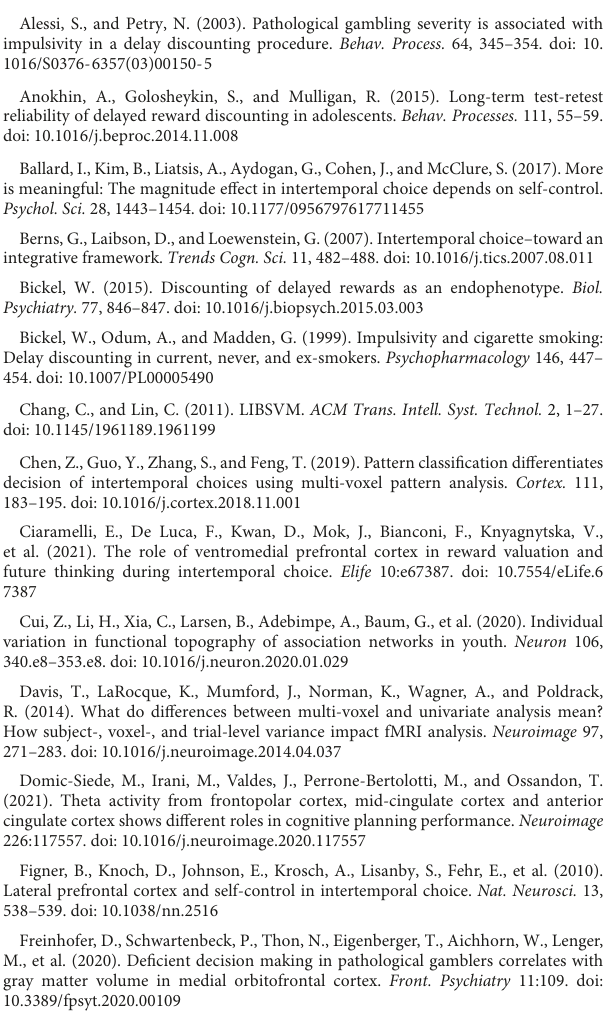
SUPPLEMENTARYFIGURE1 Corresponding results of classifications using 10-fold cross-validation strategies. (A) The whole-brain weighted map of the first classifier (classify LL vs. SS) and (B) the top 1% voxels with highest weights (absolute value). Specially, all these voxels were with positive weights. (C) The whole-brain weighted map of the second classifier (classify high impulsive individual vs. low impulsive individual) and (D) the top 1% voxels with highest weights (absolute value). Specially, all these voxels were with negative weights. The color bar indicates weight